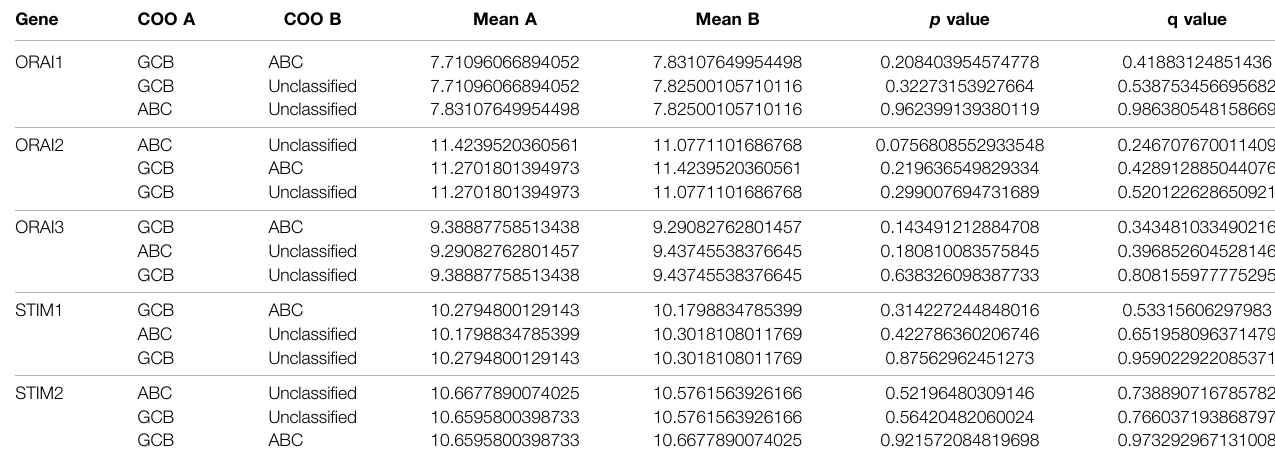
TABLE 4 | Comparisons of ORAI/STIM expression in DLBCL patient samples. The p value and q value for each comparison are shown. Gene COO